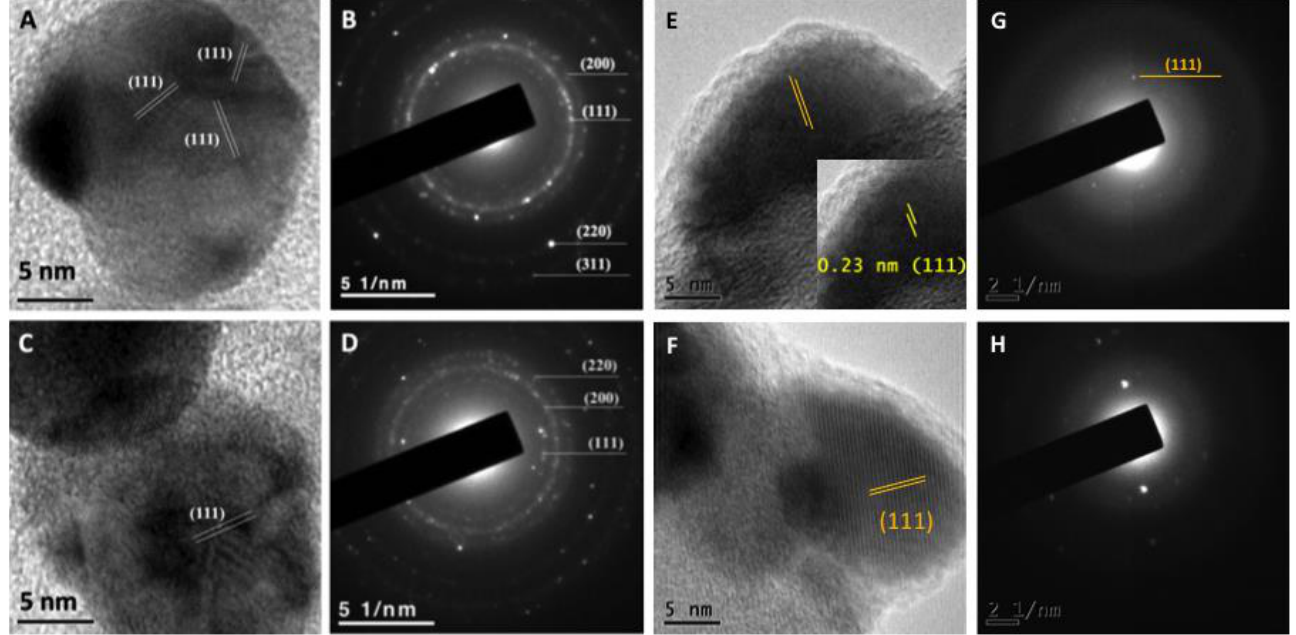
Figure 5. High-resolution transmission electron microscopy of AgNPs synthesized using the supernatant of T. harzianum ( A ) and G. sessile ( C ) with planes (111) and the corresponding diffraction pattern ( B , D ) indicating the crystalline structure. HRTEM image ( E ) and SAED pattern ( G ) of the Ag nanoparticles obtained with T. harzianum supernatant and HRTEM micrograph ( F ) and SAED pattern ( H ) of Ag synthetized with G. sessile supernatant, respectively.